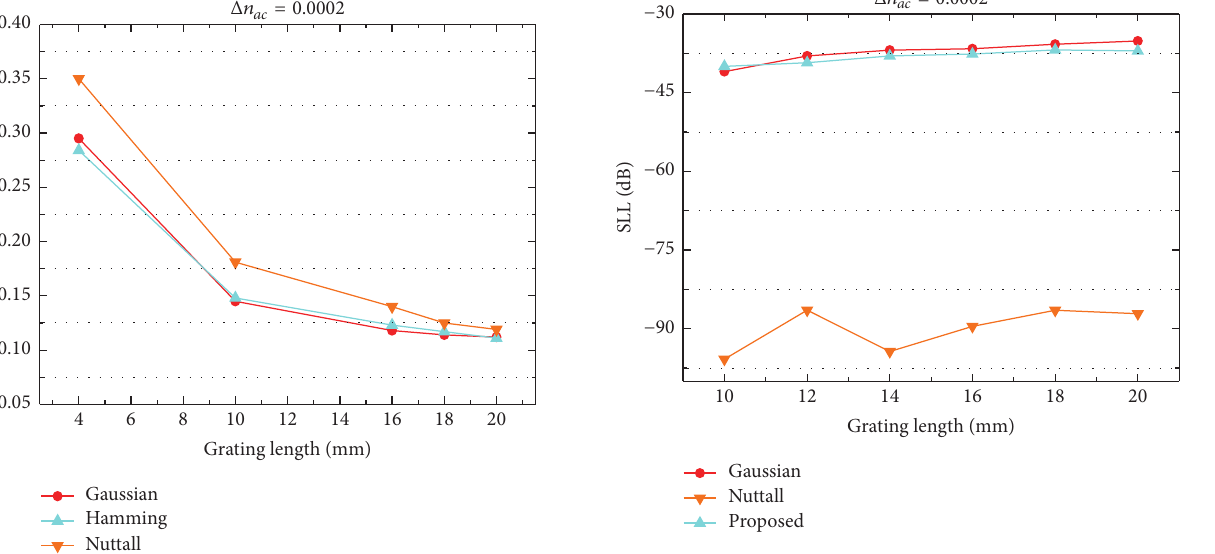
Figure 9: Side lobe level versus grating